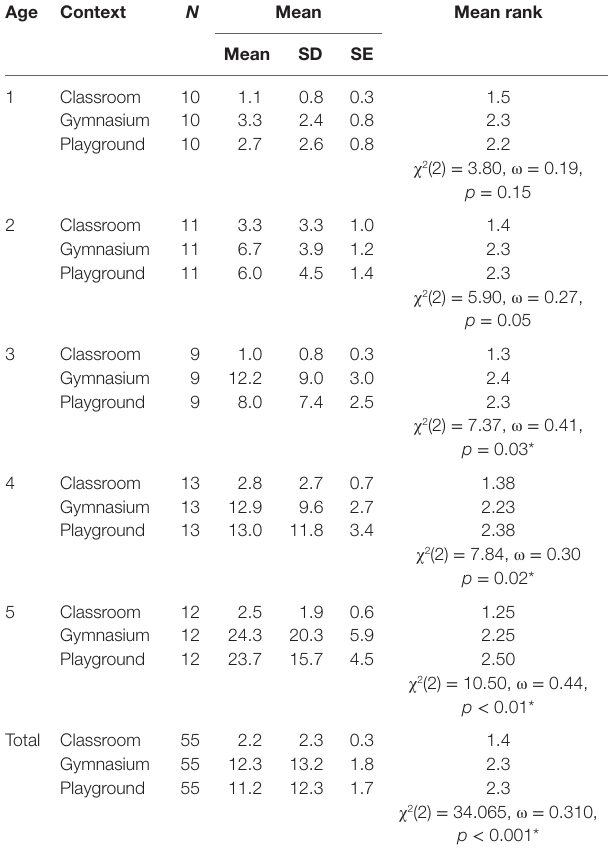
TaBle 1 | social mobility (% time) group means, sD, se, mean rank, and results of Friedman’s rank Test contexts by